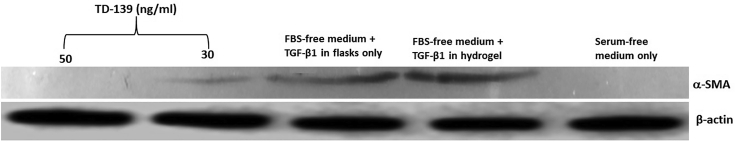
Western blot analysis of α-SMA and β-actin expression following the treatment of cell-loaded hydrogels with TGF-β1 with/without 30 and 50 ng/mL TD-13910 μg proteins were added to each lane of 12% SDS-PAGE, followed by western blotting for α-SMA expression then for β-actin as the house-keeping protein. The molecular weight of α-SMA is around 44 kDa and for β-actin is 42 kDa.